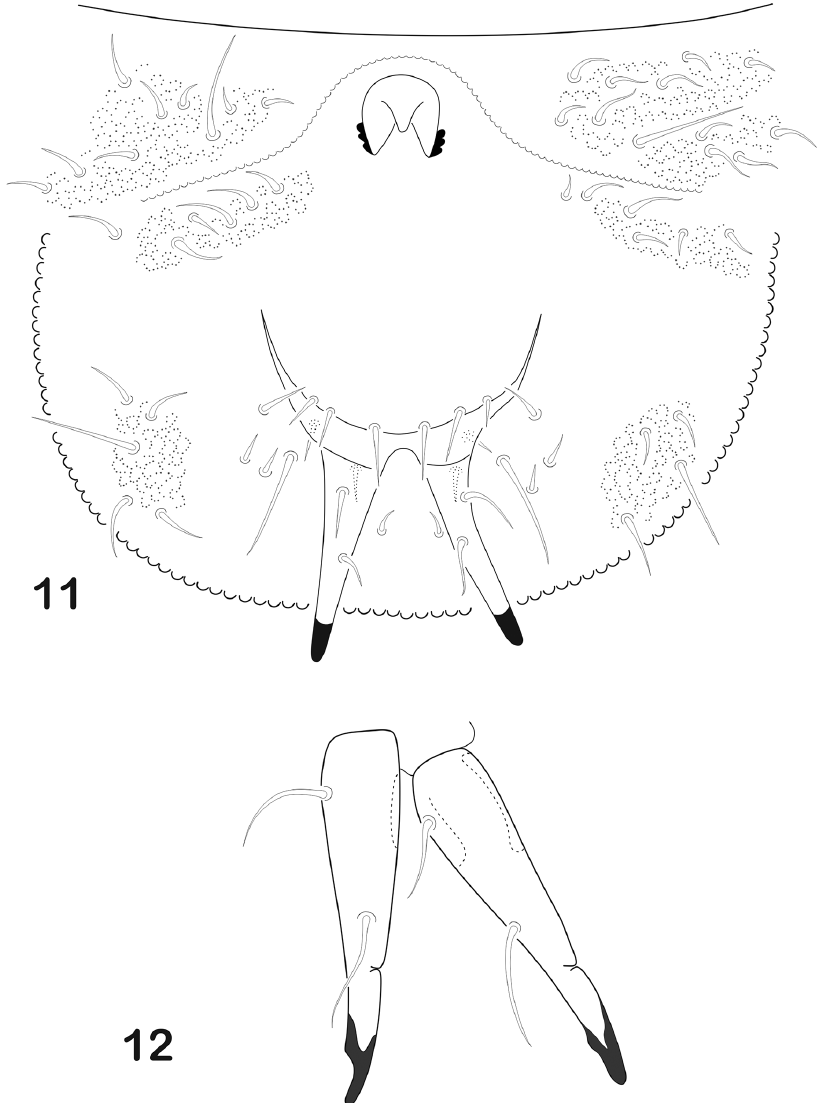
Figures 11, 12. Acheroxenylla lipsae sp. nov. 11. Ventral abdominal chaetotaxy from Abd. III to V, with retinaculum and furcula; 12. two mucrodens in lateral position.